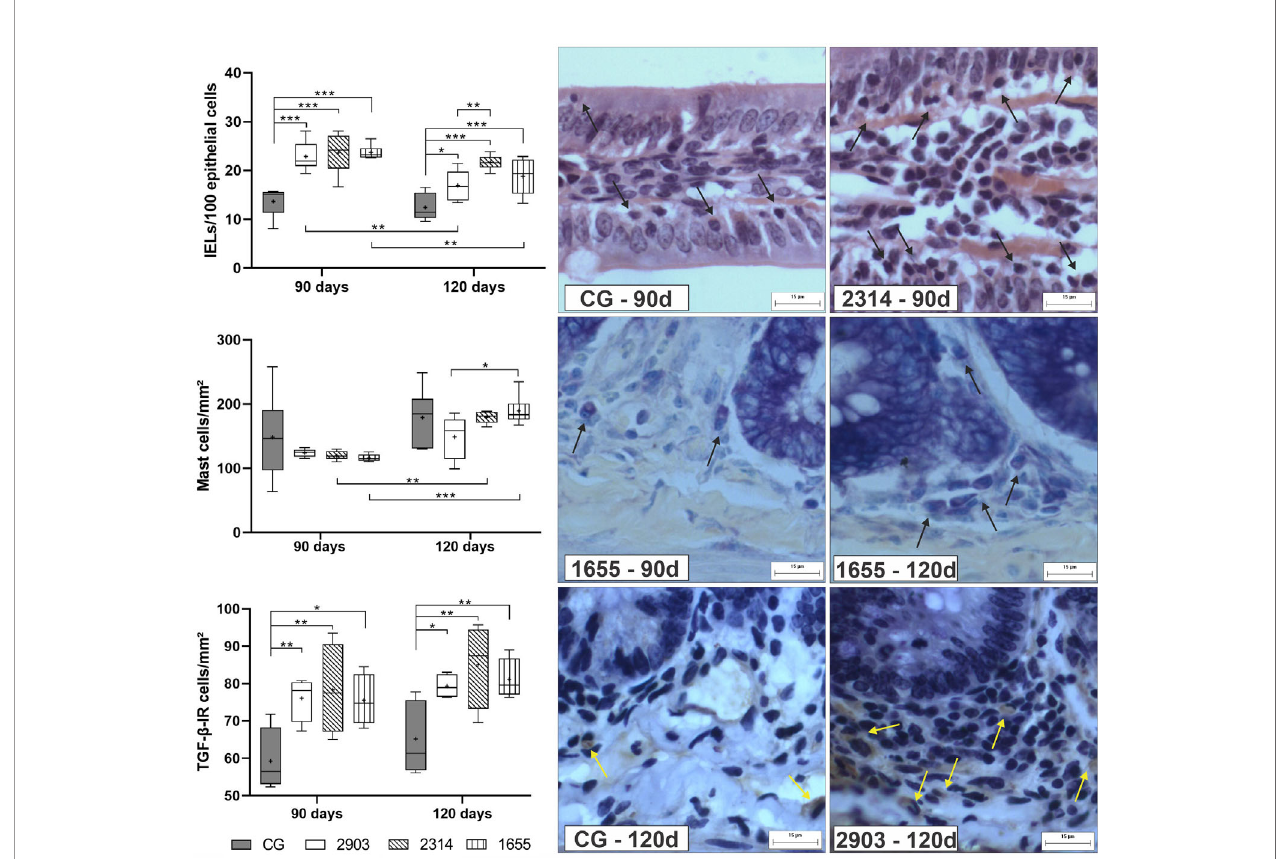
FIGURE 8 | Proportion of intraepithelial lymphocytes (IELs) in 100 epithelial cells, mast cells, and TGF- b -immunoreactive cells (TGF- b -IR) per mm². Data represented in box plots (median with 25 to 75 percentile), whiskers (2.5 to 97.5 percentile), and mean (+) ( n = 6). * p < 0.05; ** p < 0.01; *** p < 0.001. Representative photomicrograph of IELs in the control group and 2314 at 90-days post infection (black arrows; HE staining, 40× magni fi cation, scale bar = 15 μm, Olympus BX50); mast cells in group 1655 at 90- and 120-days post infection (black arrows; blue toluidine staining, 40× magni fi cation, scale bar = 15 μm, Olympus BX50); TGF- b -IR of the control group and 2903 at 120-days post infection (yellow arrows; immunohistochemistry, 40× magni fi cation, scale bar = 15 μm, Olympus BX50). CG, control group. 2903: group infected with MHOM/BR/1975/M2903. 2314: group infected with MHOM/BR/2003/2314. 1655: group infected with